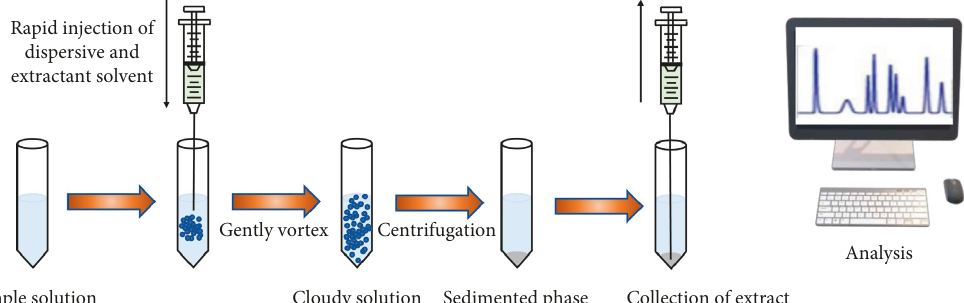
Figure 2: Schematic procedure of the dispersive liquid-liquid microextraction technique (the image is from